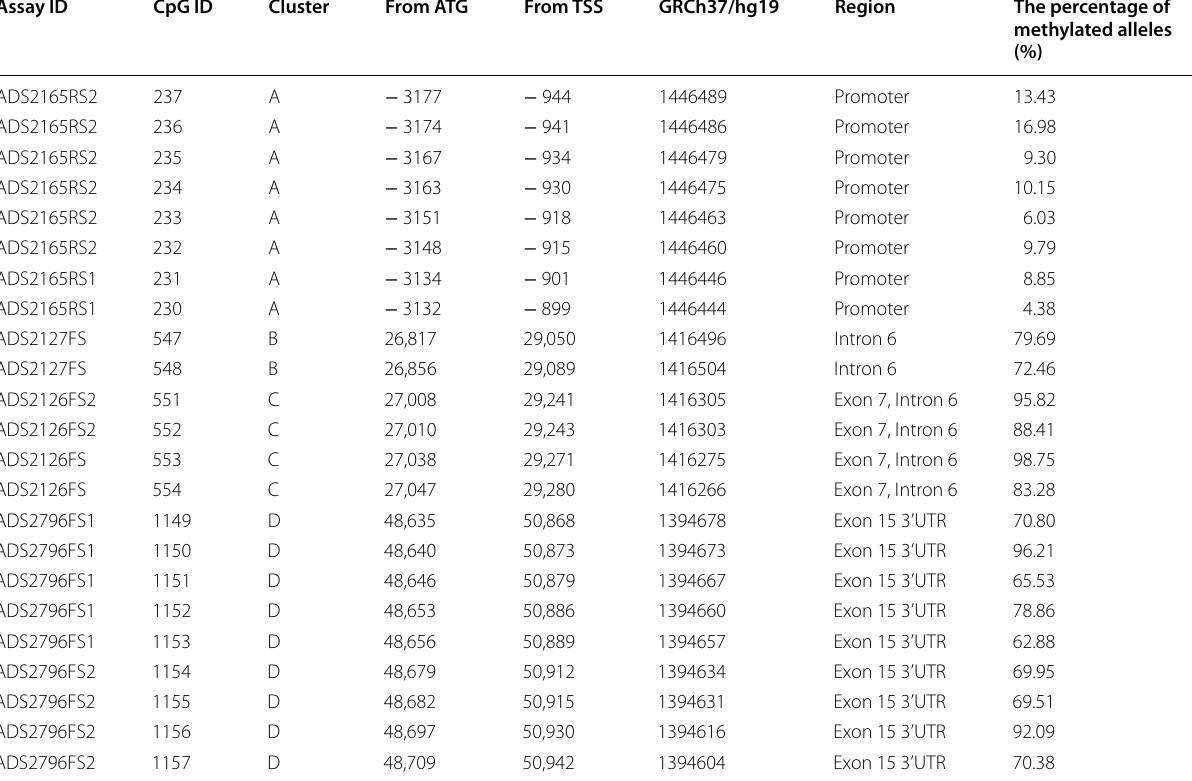
Table 1 Coordinates and the percentage of methylated alleles (%) for all SLC6A3 CpG sites